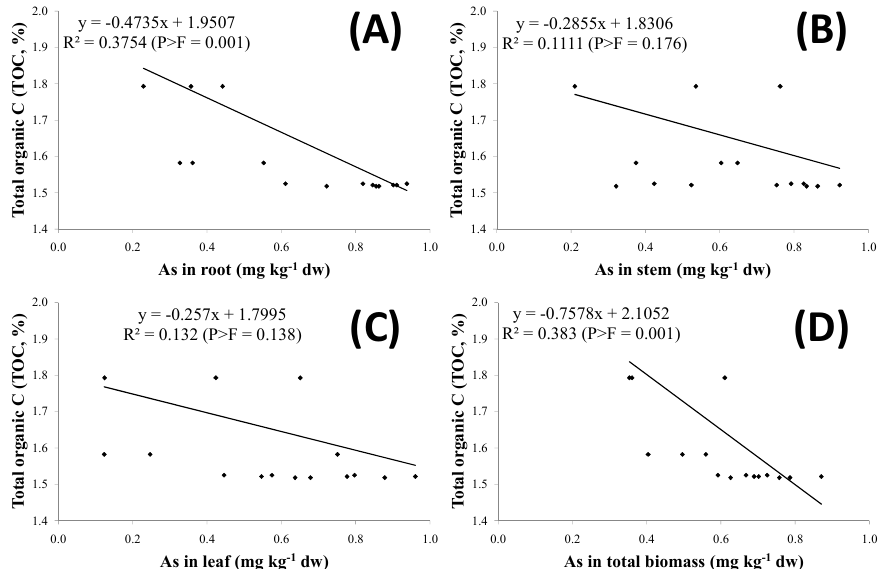
Figure 2. Relationship between total organic carbon (TOC) and As content in roots ( A ), stems ( B ), leaves ( C ) and total biomass ( D ) measured in all considered vegetable crops. Data correspond to 2012 and 2013 growing seasons.